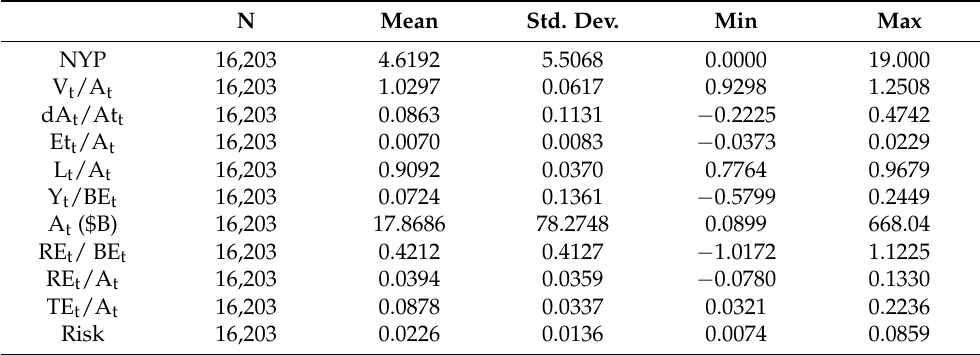
Table 2. Selected descriptive